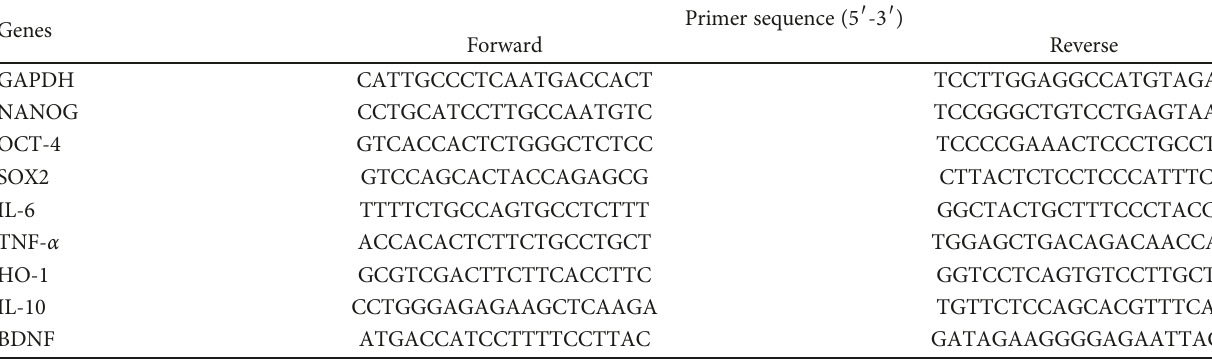
Table 1: Primers for quantitative real-time polymerase chain